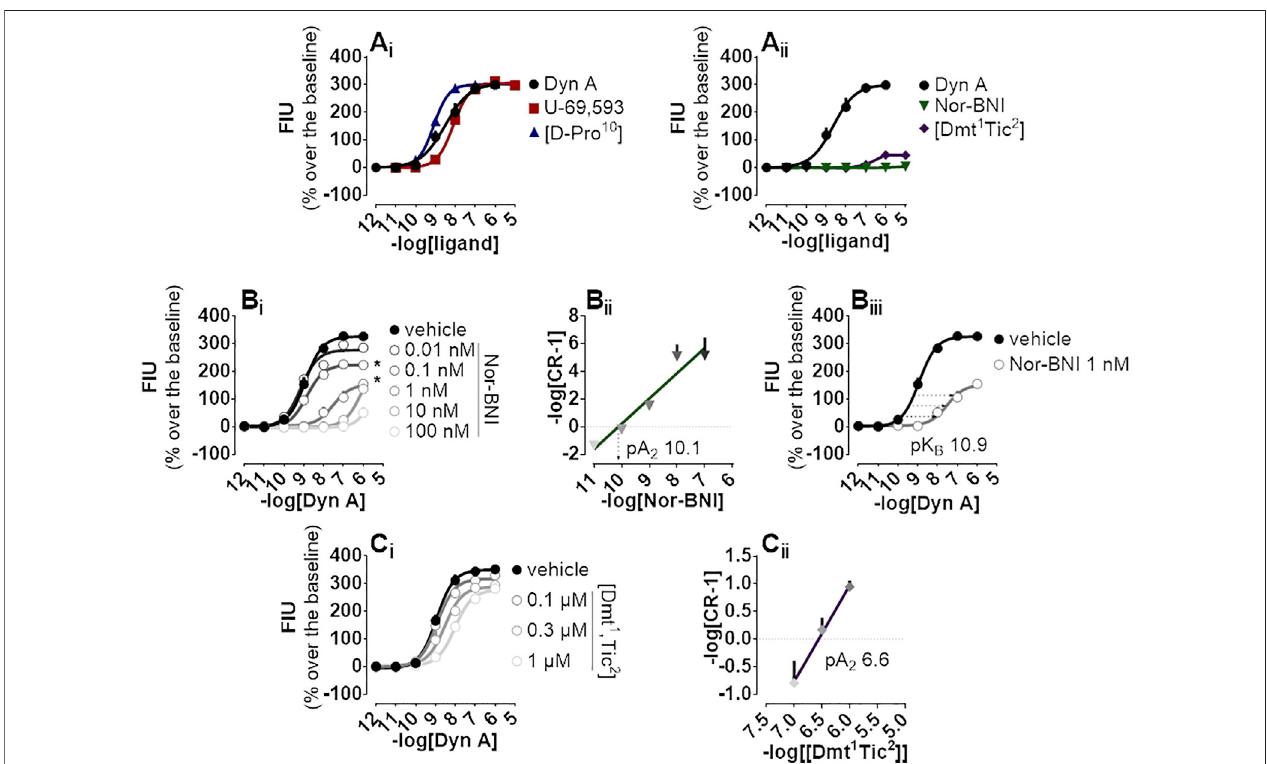
FIGURE 1 | Calcium mobilization experiments carried out in CHO cells stably expressing the human kappa opioid receptor and the G α qi5 chimeric G protein (A i ) Dyn A, U-69,593, and [D-Pro 10 ], and (A ii ) Nor-BNI and [Dmt 1 ,Tic 2 ] concentration-response curves (B i ) Concentration-response curves to Dyn A in the absence and in the presence of increasing (10 p.m. — 100 nM) concentrations of Nor-BNI, corresponding (B ii ) Schild analysis and (B iii ) computation of antagonist potency for non- competitive antagonists